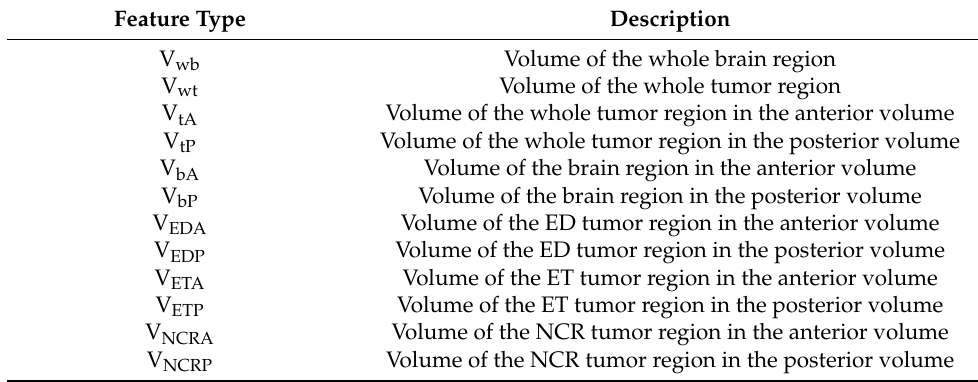
Table A2. Volumetric features extracted from mid-coronal plane